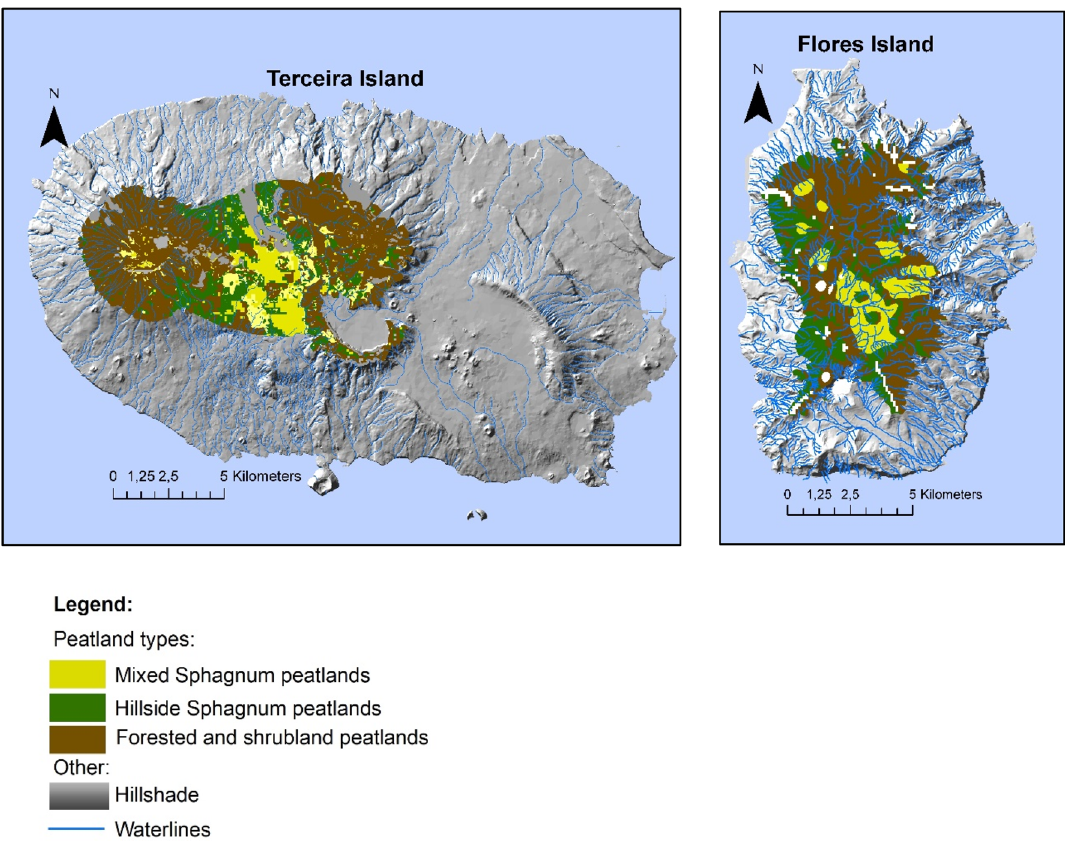
Fig. 5 Simulated potential distribution of peatlands defined for Terceira and Flores Islands. Modelling in ArcGIS